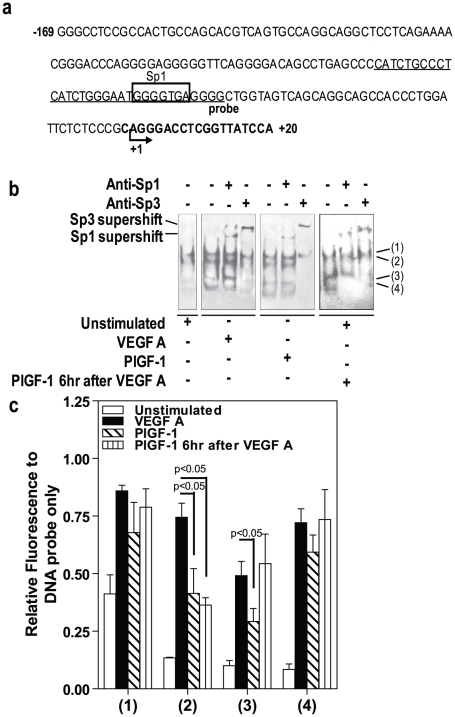
PlGF-1 regulates VE-cadherin expression through the trans-activating Sp1 and Sp3 interaction with the VE-cadherin promoter.(a) Nucleotide sequence of the -169/+20 region of the VE-cadherin gene. All numberings are related to the transcriptional start site (+1). The sequence belonging to the first exon is boldface. The sequence of oligonucleotide probe is underlined, and putative Sp1 (GT box) is boxed. (b) Representative EMSA analysis of microvascular endothelial nuclear proteins binding to Sp1 recognition sequences with the promoter of the VE-cadherin gene in response to vehicle (unstimulated), VEGFA alone, hPlGF-1 alone and hPlGF-1 6 hours following VEGF. VEGFA and hPlGF-1 were used at 100 ng/ml. VEGFA and PlGF alone or in combination. Supershift complexes were observed with anti-Sp1 and anti-Sp3 antibodies, respectively, indicating Sp1 and Sp3 binding to the GT box (n = 3). From the top to bottom (1)  =  first band; (2)  =  second band; (3)  =  third band and (4)  =  fourth band. (c) Quantitative analysis of the trans-activating Sp1 and Sp2 interaction with the VE-cadherin promoter. The fluorescent density of the bands were normalized to the fluorescent density of VE-cadherin promoter oligonucleotide probe. Data are represented as means ± s.e.m. *p<0.05, ** by p<0.01 (Mann-Whitney U test).